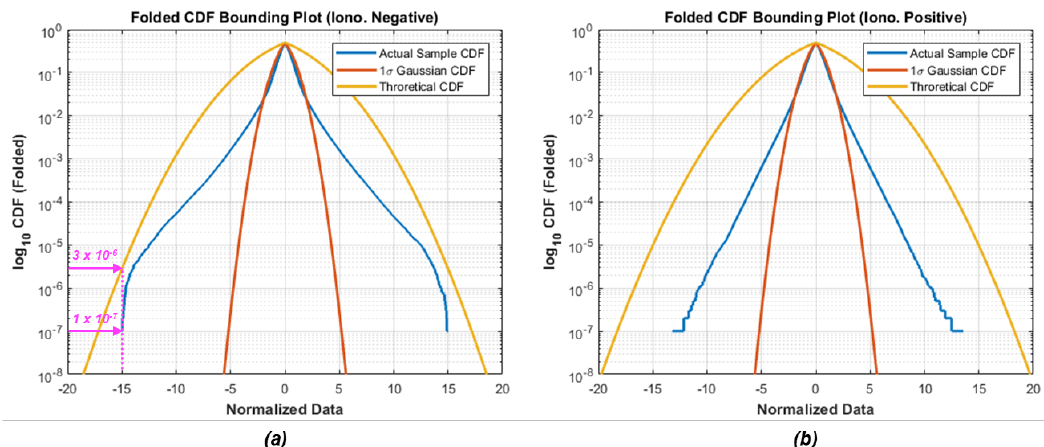
Figure 3. Probability density function of nominal monitoring values: ( a ) ionospheric negative acceleration; ( b ) ionospheric positive acceleration.